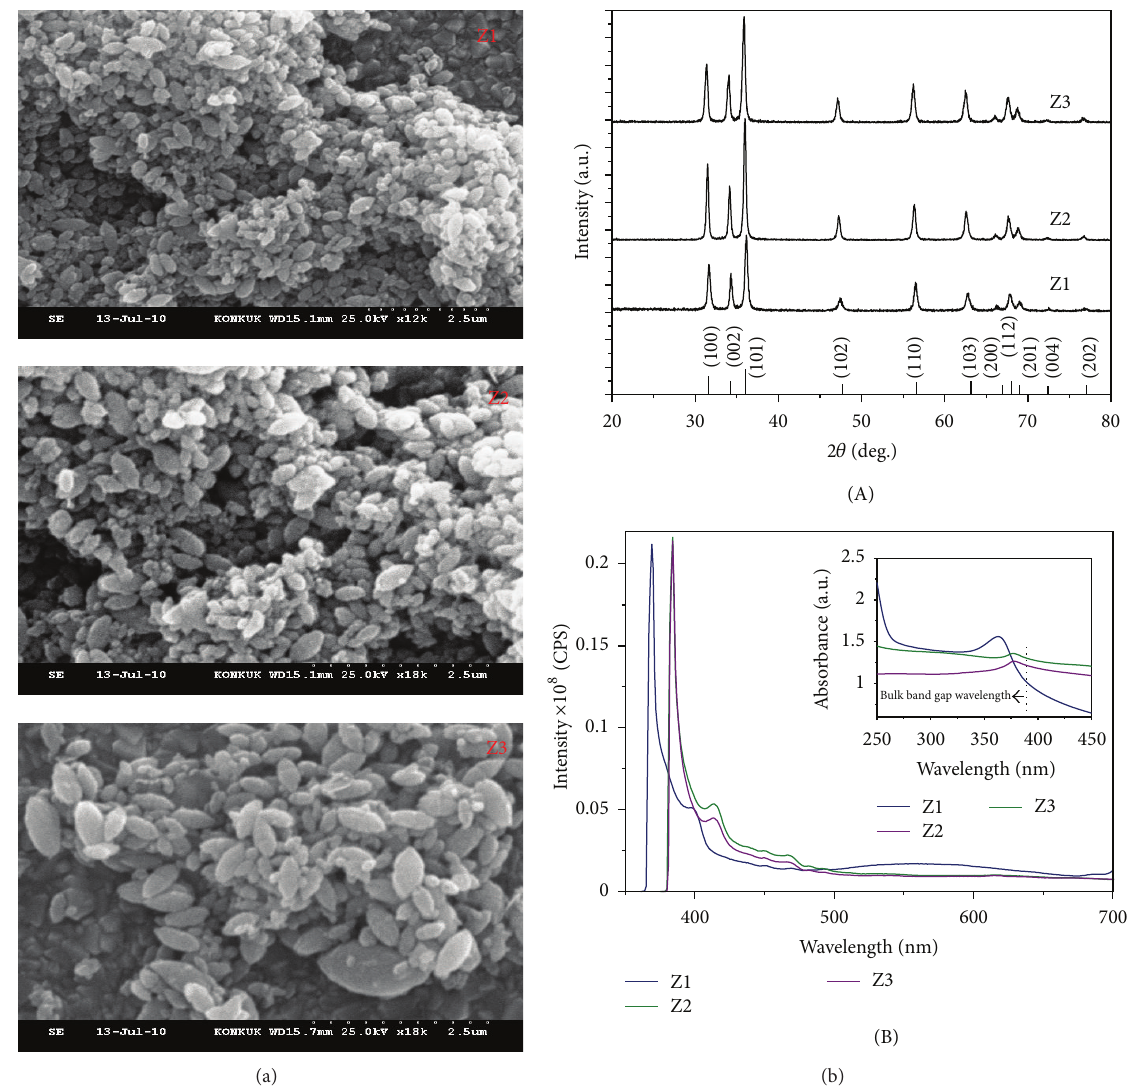
Figure 1: (a) Scanning electron microscopic (SEM) images (on FTO) and (b) X-ray diffraction (XRD) pattern (A) and photoluminescence spectra in ethanol (inset, the corresponding UV-visible absorption spectra) (B) of Z1, Z2, and Z3 grains.